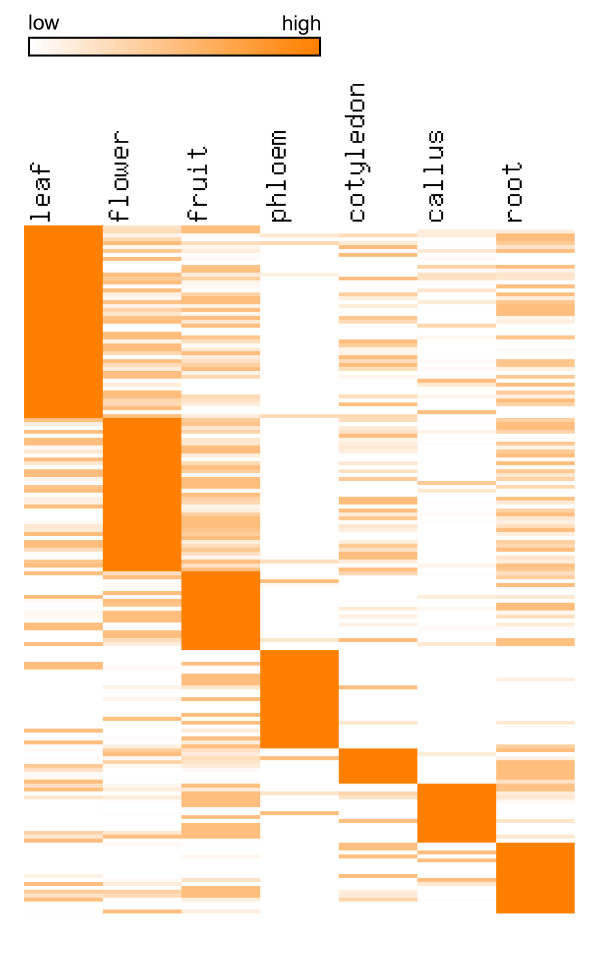
Heatmap representation of expression profiles of melon tissue-specific genes.